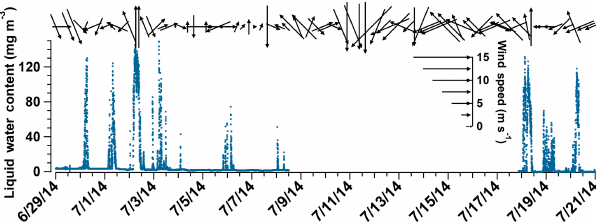
Figure 1. Wind speed and direction during fog sampling period, shown as vector arrows (top): speed is displayed as the length of each arrow and direction is displayed as tilt, pointing away from wind origin. LWC measured during the entire study period is shown in blue along the bottom of the plot. Fog was not collected in mid- July during the monsoonal